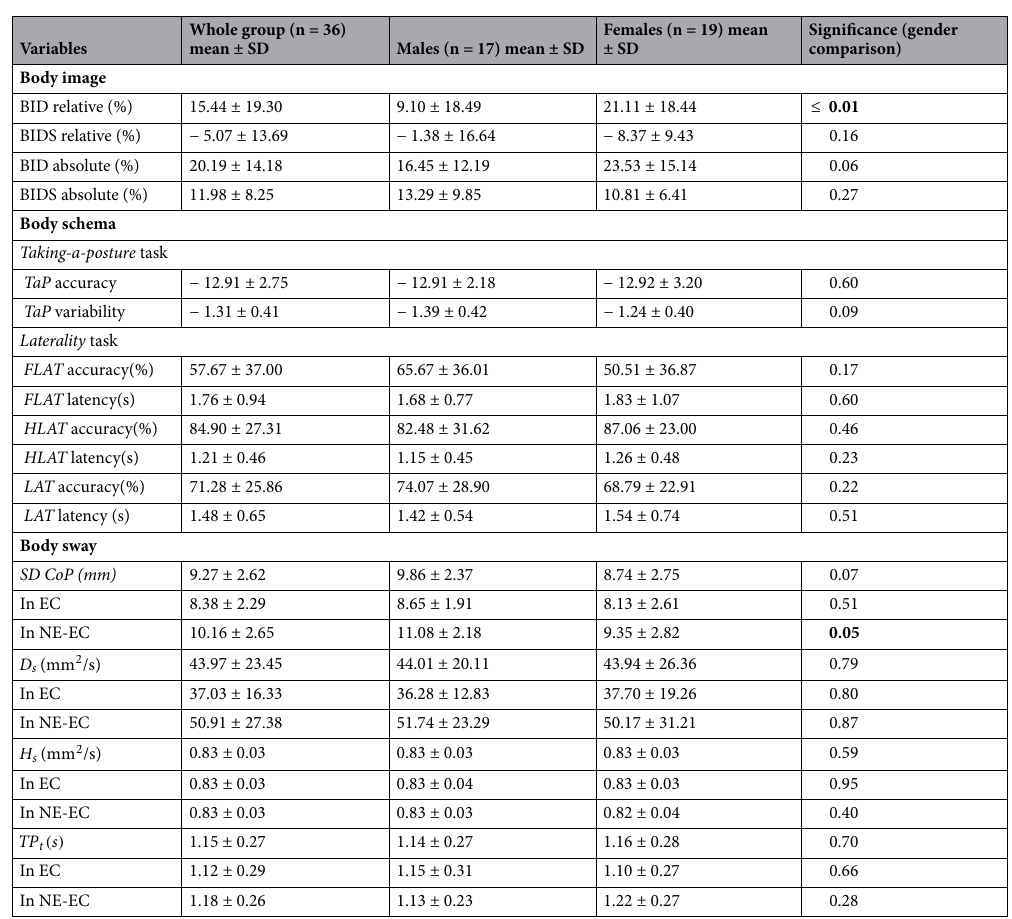
Table 2. Subject characteristics and group comparisons (t-tests and Mann–Whitney-U tests) for body representations (body image, body schema) and body sway. BID body image distortion, BIDS body